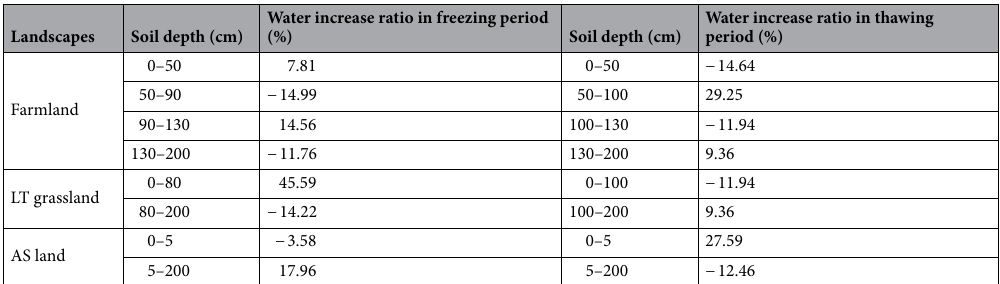
Table 2. Soil water increase ratio of farmland, LT grassland and AS land in freezing period and thawing period.